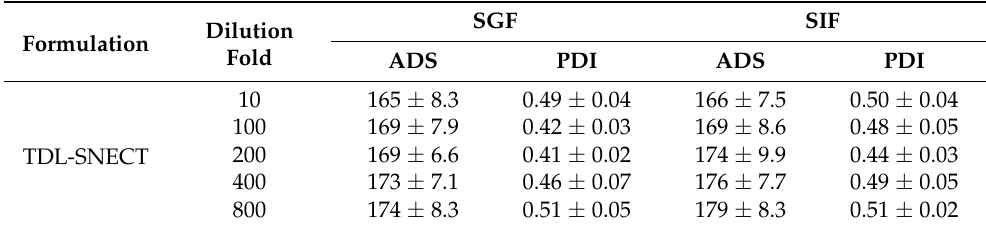
Table 7. Effect of dilution with simulated GI fluids on self-nanoemulsifying chewable tablets (SNECT)